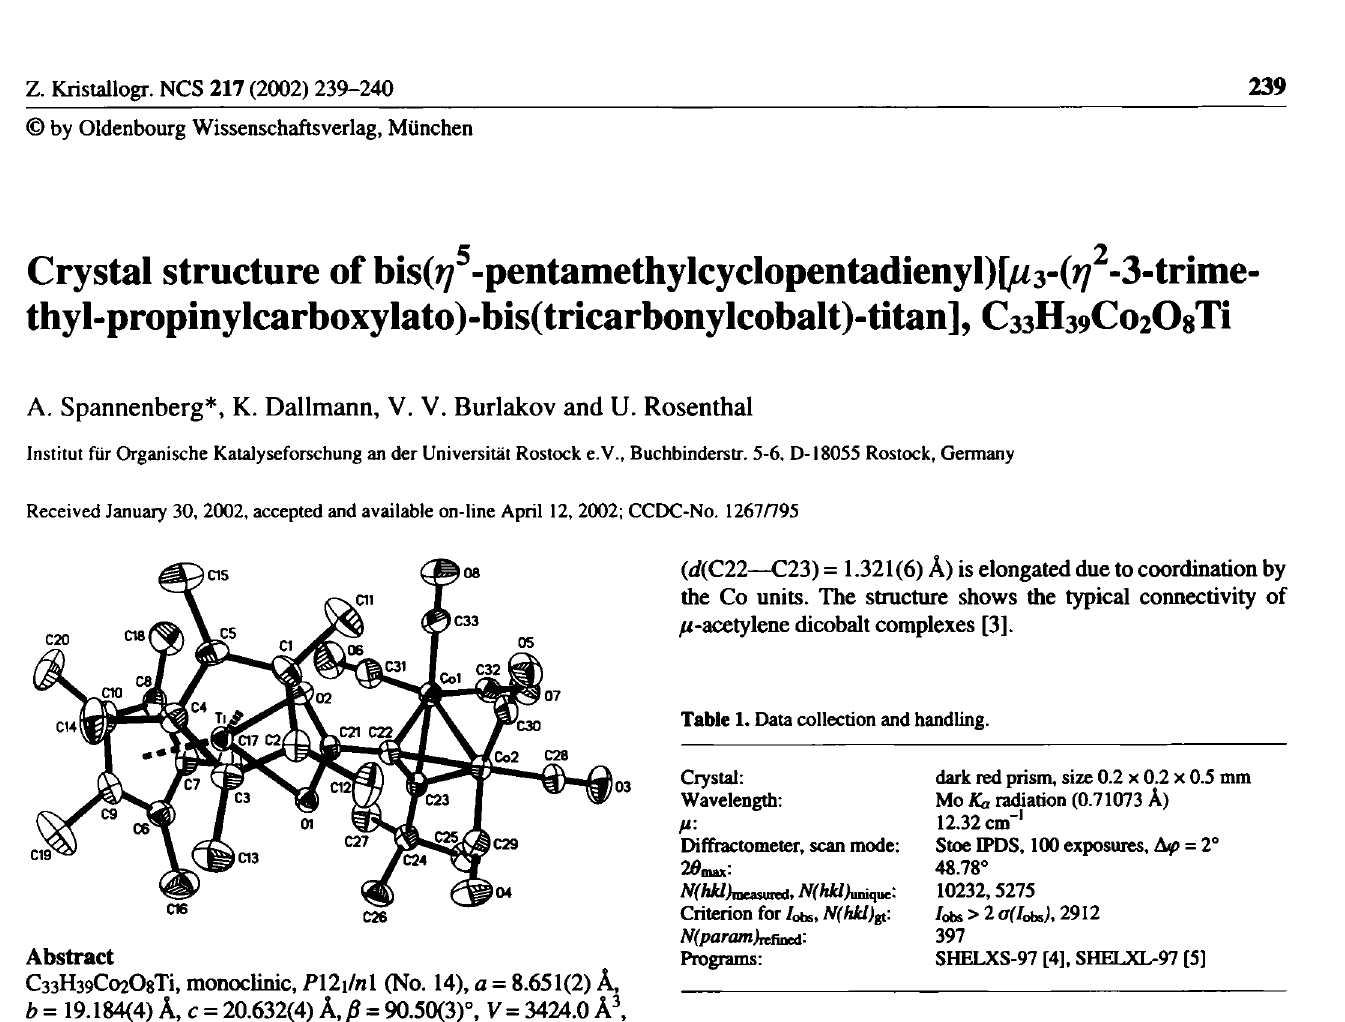
Table 2. Atomic coordinates and displacement parameters (in Â 2